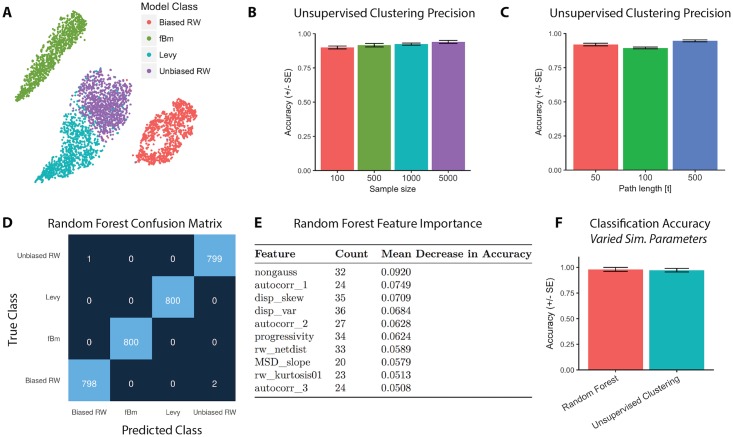
Simulated models of motion can be differentiated based on Heteromotility features.(A) Representative t-SNE visualization of Heteromotility feature space determined for simulated motion models (1000 members/class, 100 time steps)(perplexity = 50). (B) Unsupervised clustering accuracy for simulated data across a range of sample sizes and (C) track lengths. (D) The Confusion Matrix of a representative Random Forest classifier trained to distinguish four simulated models of motion shown in (A), mean accuracy of 99.8% (5-fold CV). (E) Features ranked by importance for Random Forest classification, where importance is determined as the decrease in accuracy when the feature is removed across all 36 simulated sample populations. The number of times the feature appears in the top 10 most important across the 36 populations is reflected in the ‘Count’ column. (F) Accuracy of classifying simulated motion models with varying parameters using hierarchical clustering and a Random Forest classifier. 10 populations of the four simulated motion models with varied parameters were generated and classified.